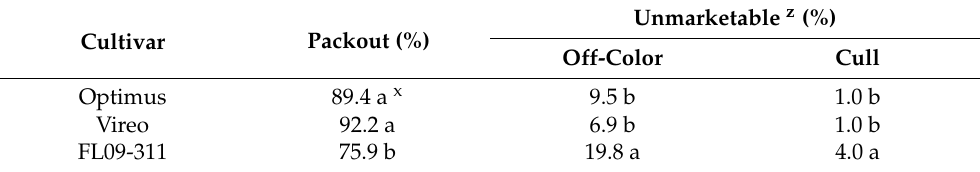
Table 1. Packout distribution on day of harvest for “Optimus”, “Vireo”, and “09-311” blueberries for combined mechanical harvest methods. All fruit from Harvest 1 were manually sorted in the laboratory. Cultivar